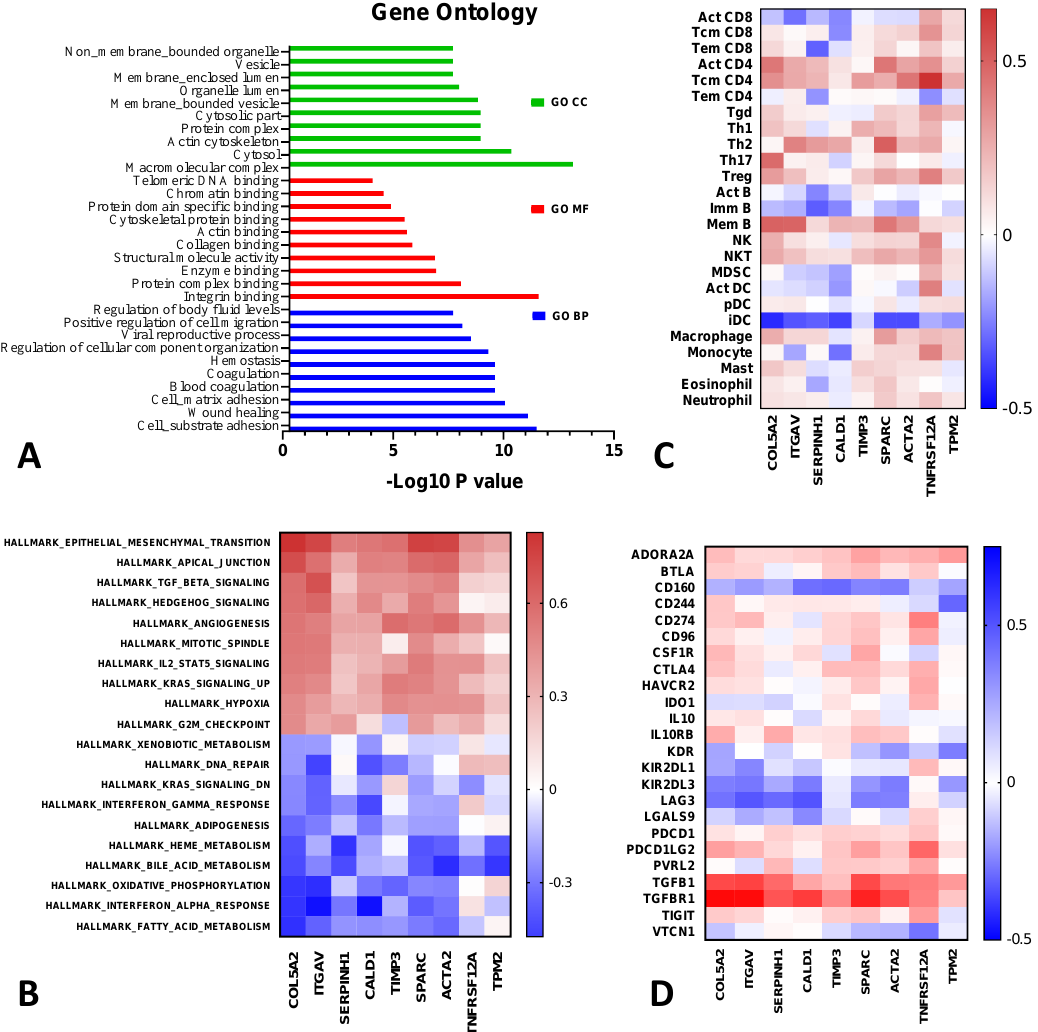
Figure 4. Gene ontology and heatmap correlating the MESO EMT genes with the immune profile. ( A ) Gene ontology (GO) enrichment analysis for the MESO EMT genes in biological process (BP), cellular component (CC), and molecular function (MF). ( B ) Hallmark enrichment gene sets positively and negatively correlating with the MESO EMT genes by NetworkAnalyst. ( C ) EMT gene expression correlating with tumor-infiltrating lymphocytes (TIL) in heatmap. ( D ) Correlation between EMT gene expression and immune exhaustion markers in